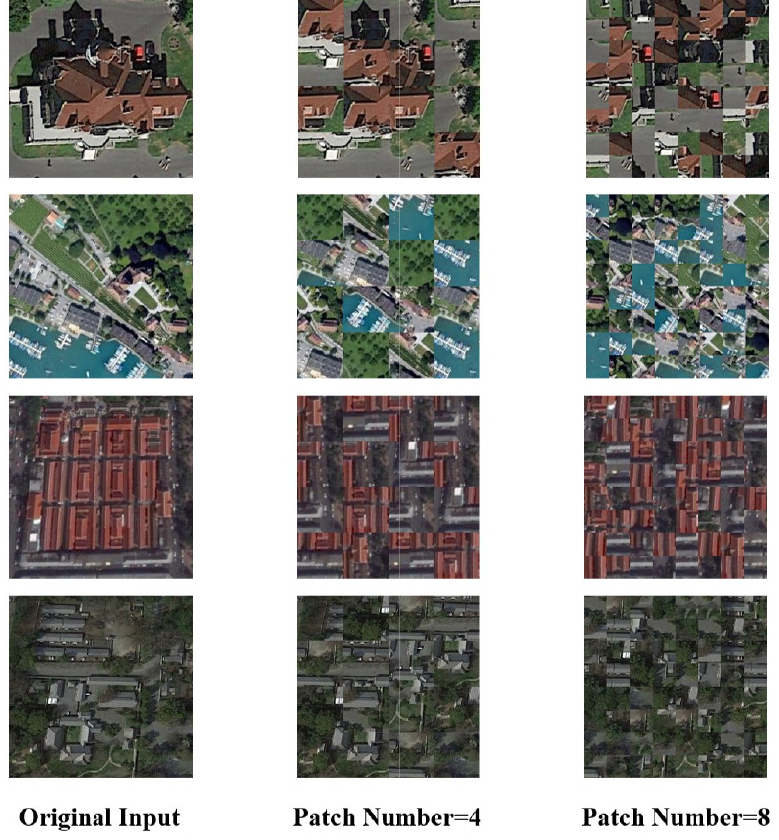
Figure 2. Destruction operation of the spatial layout of input